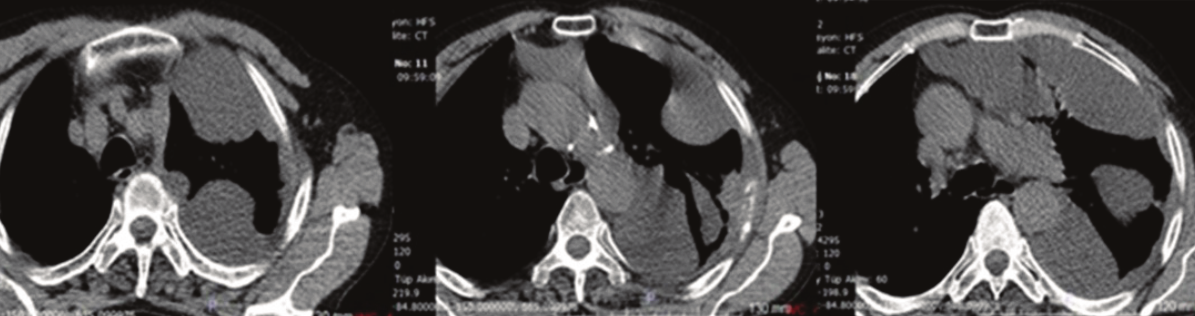
Figure 2: Thorax CT showing pleural fluid accumulation and pleural thickening areas, accompanied by pleural nodules in the left hemithorax.